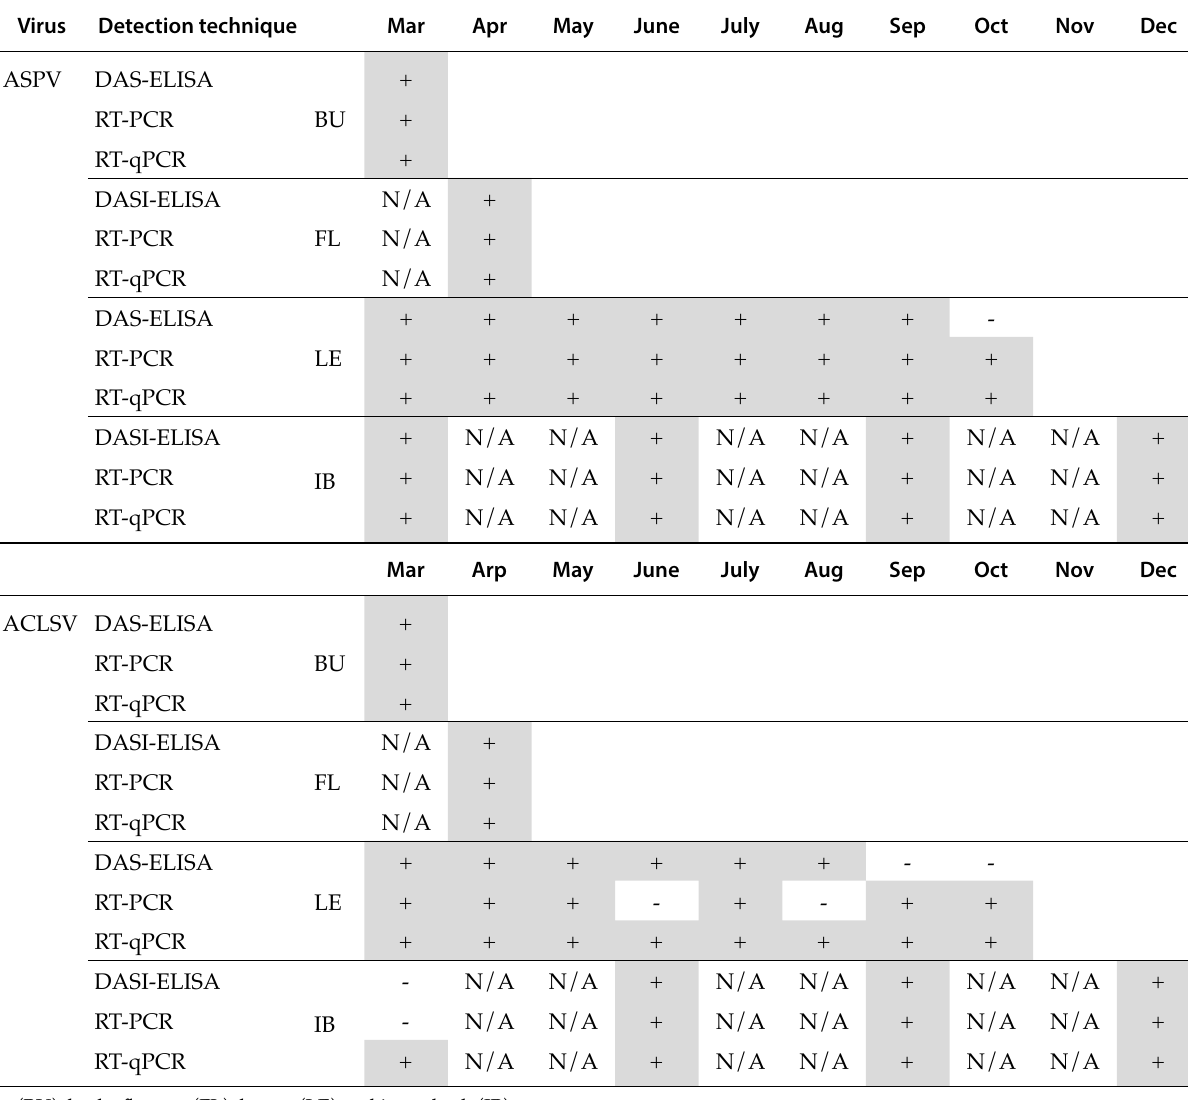
Table 5. Comparison between the reliability of DAS/DASI ELISA, RT-PCR and RT-qPCR for the detection of Apple stem pitting and Apple chlorotic leaf spot virus in different plant tissues in different months of